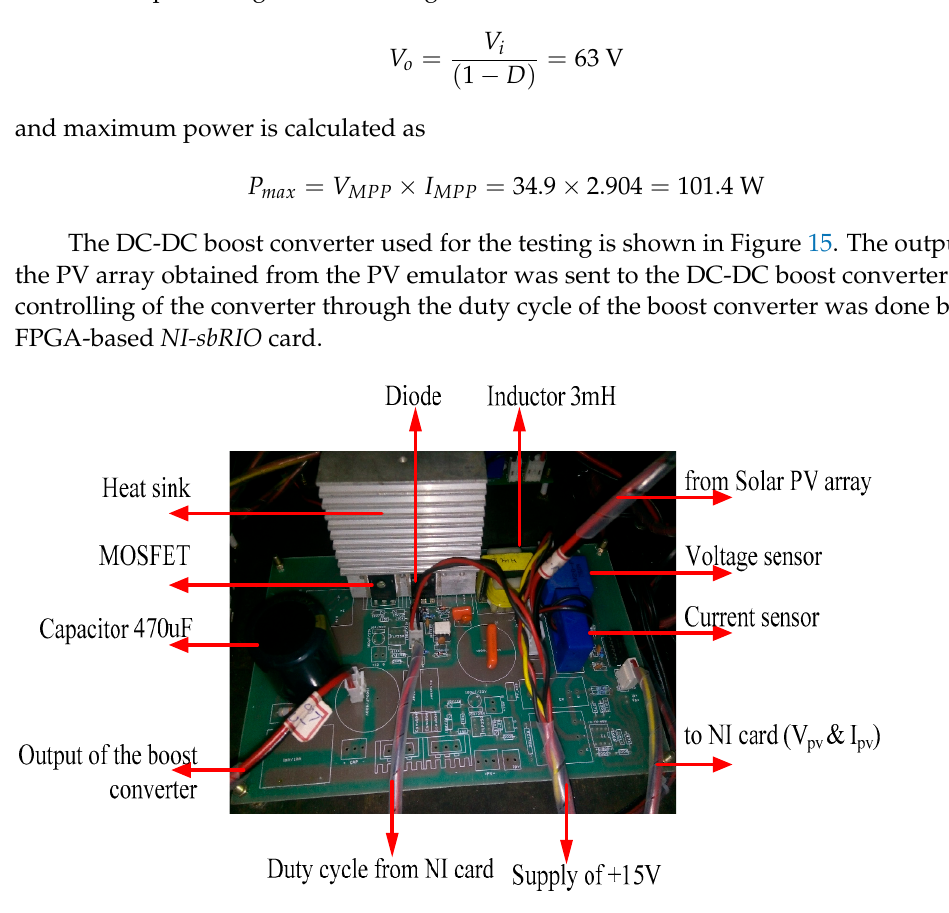
Figure 15. DC-DC boost